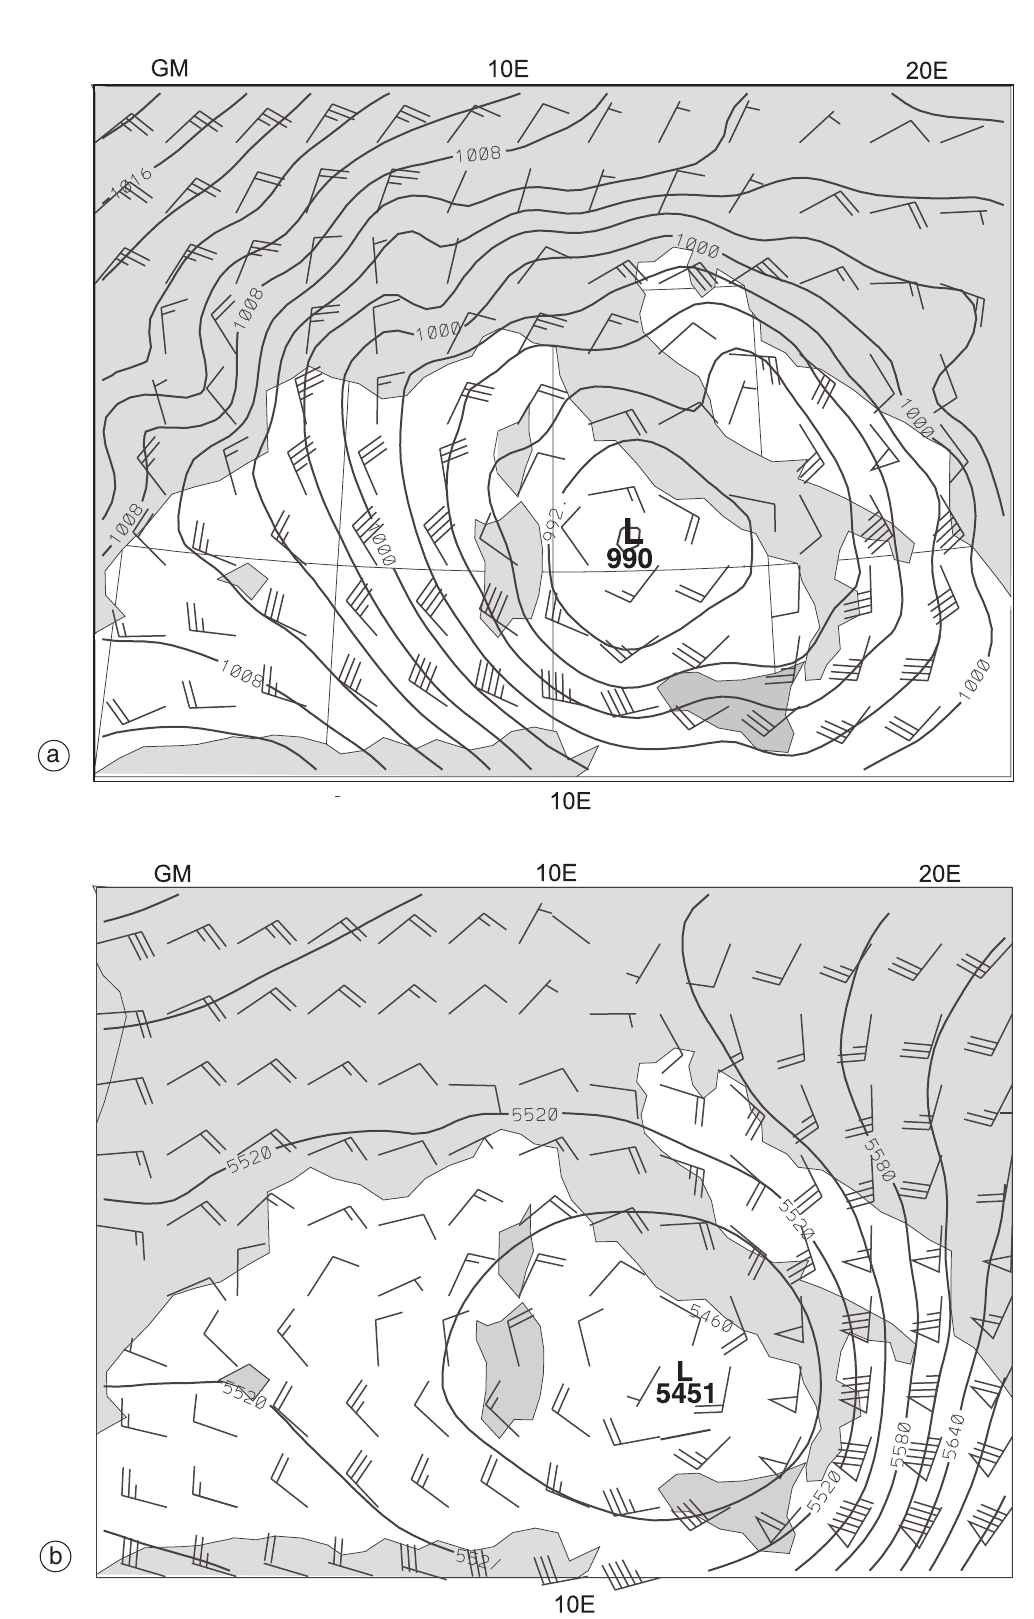
Fig. 2a,b. Ecmwf data analyses for 4th May at 0000UTC: a) sea level pressure (c.i. = 2 hPa) and wind (one barb = 10 knots) at 925 hPa; b) 500 hPa-height fi eld (c.i. = 30 m) and wind (one barb = 10